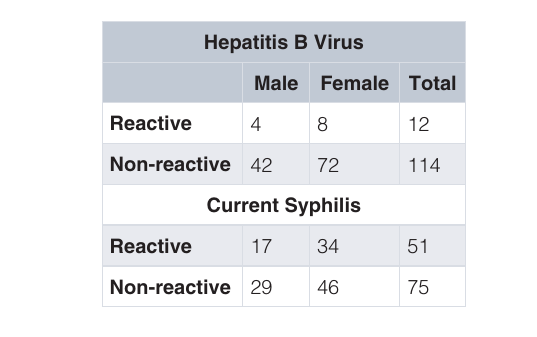
Table 2. HIV, HBV and syphilis